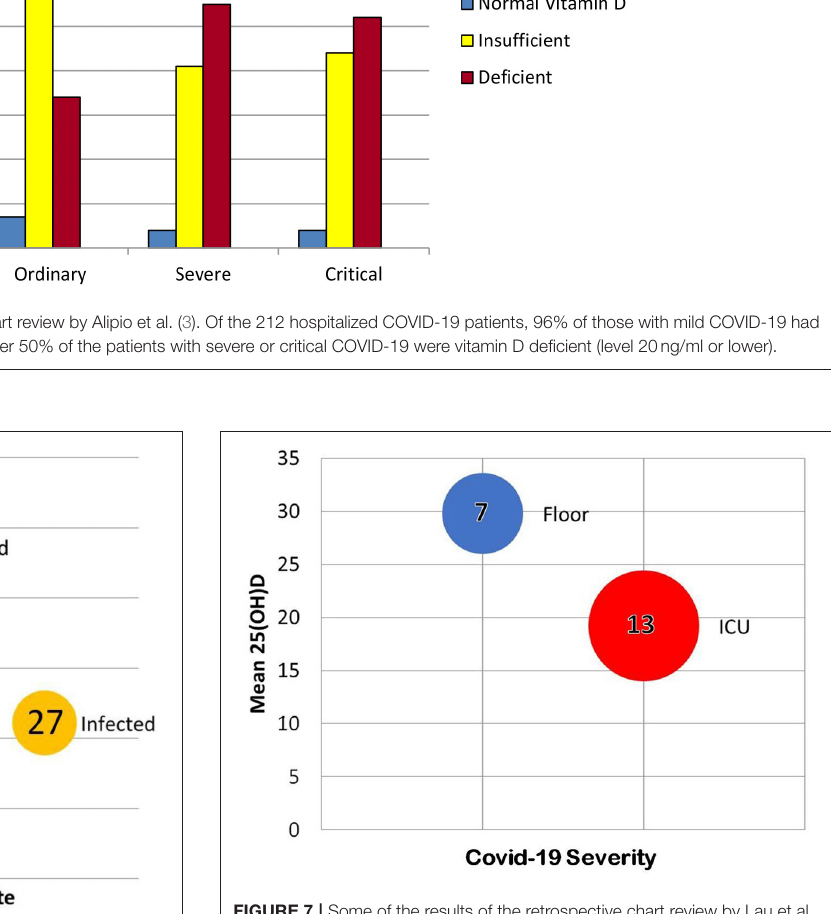
FIGURE 6 | Some of the results of the retrospective chart review by D’Avolio et al. (124). In the 107 individuals tested for both 25(OH)D and COVID-19, vitamin D predicted infection.